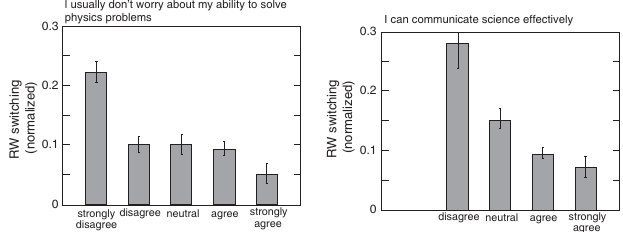
FIG. 4. Average right-to-wrong switching (normalized) for students with different levels of agreement with the statements “ I usually don ’ t worry about my ability to solve physics problems ” (left) and “ I can communicate science effectively ” (right). No students strongly disagreed with the statement “ I can communicate science effectively ” and therefore this column is missing from the figure on the